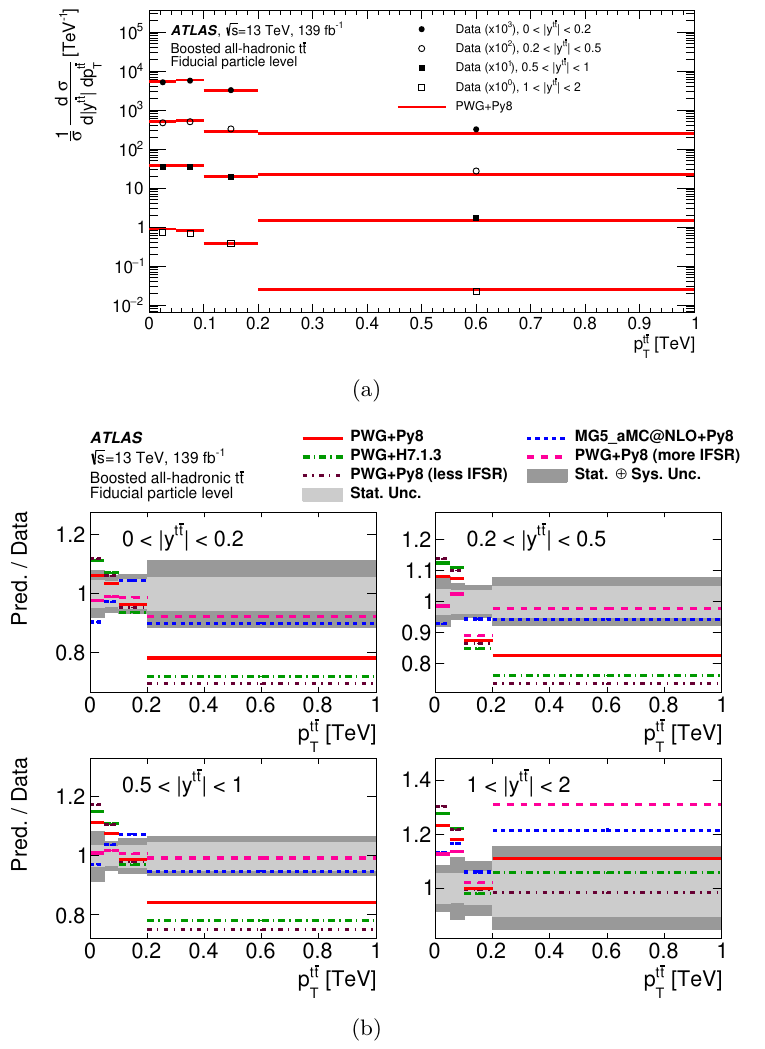
Figure 19 . (a) Normalized particle-level fiducial phase-space double-differential cross-sections as a function of the absolute value of the rapidity and the p T of the t ¯ t final state, with the Powheg+Pythia 8 calculation. Data points are placed at the centre of each bin and the Powheg+Pythia 8 calculation is indicated by solid lines. The measurement and the prediction are normalized by the factors shown in parentheses to aid visibility. (b) The ratios of various MC calculations to the normalized particle-level fiducial phase-space differential cross-sections. The dark and light grey bands indicate the total uncertainty and the statistical uncertainty, respectively, of the data in each